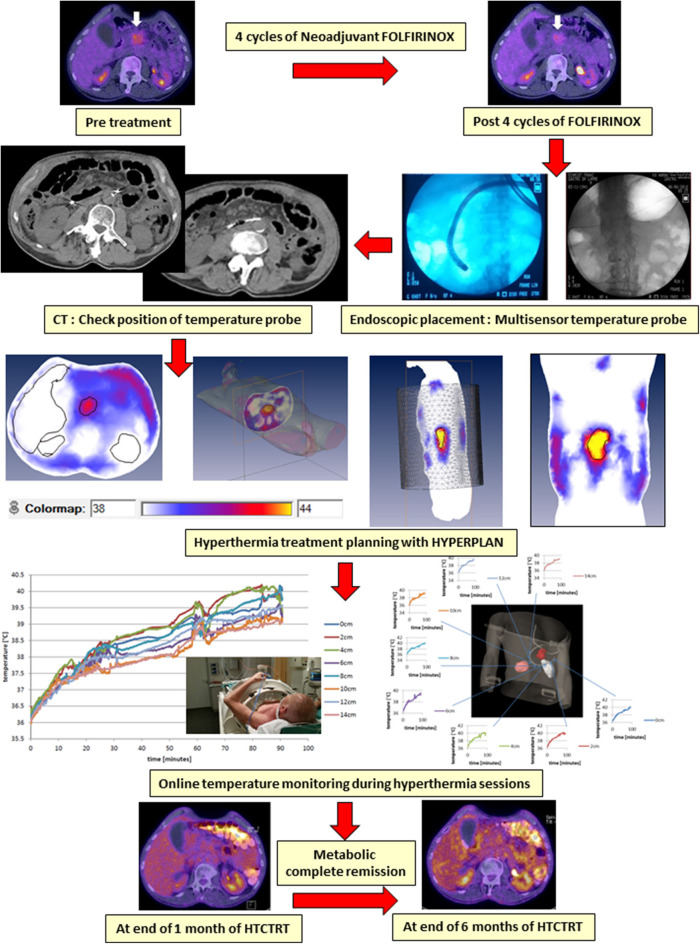
An illustrative example of a patient with locally advanced pancreatic cancer being treated with hyperthermia and radiotherapy as per the HEATPAC protocol (264). Multisensor thermometry probes are guided through the endoscope and placed in the duodenum. Hyperthermia treatment plan is obtained using HYPERPLAN, and the online temperature monitoring is carried out during the hyperthermia. The tumor shows metabolic complete remission on PET obtained at 6 months following the treatment with hyperthermia, radiotherapy, and chemotherapy (HTCTRT).